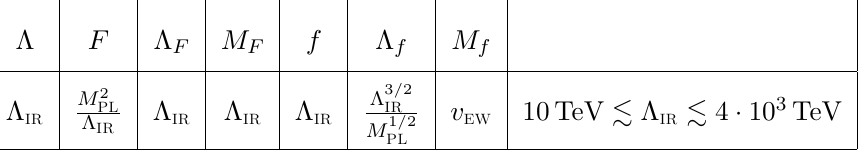
Table 2 . Parameters in the potential in eq. (3.2) in our warped model with an electroweak-scale barrier. The range for the IR scale is allowed by all phenomenological constraints considered in this